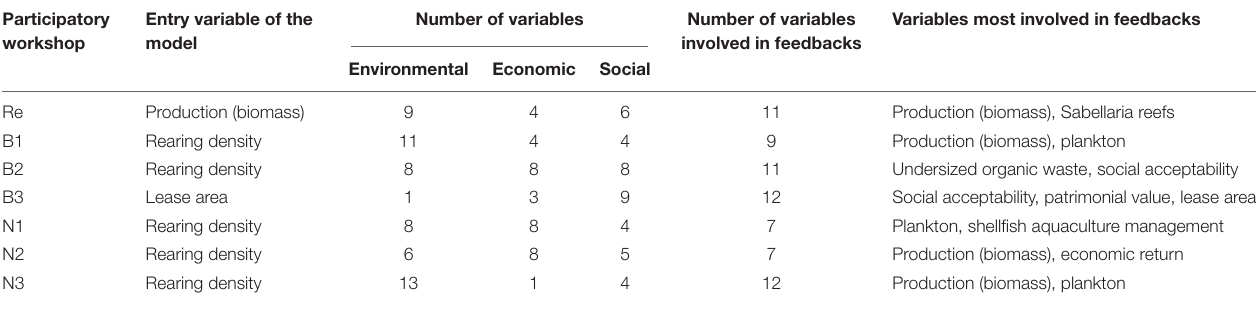
TABLE 2 | Characteristics of the models built in the seven